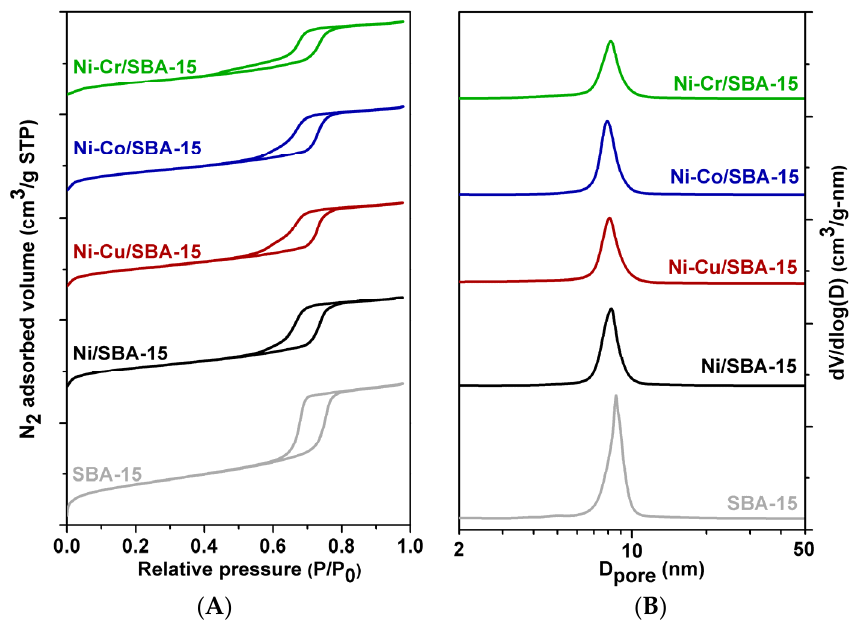
Figure 1. N 2 adsorption-desorption at 77K of SBA-15 support and the Ni-(Cu,Co,Cr)/SBA-15 catalysts: ( A ) isotherms; and ( B ) pore size distribution.